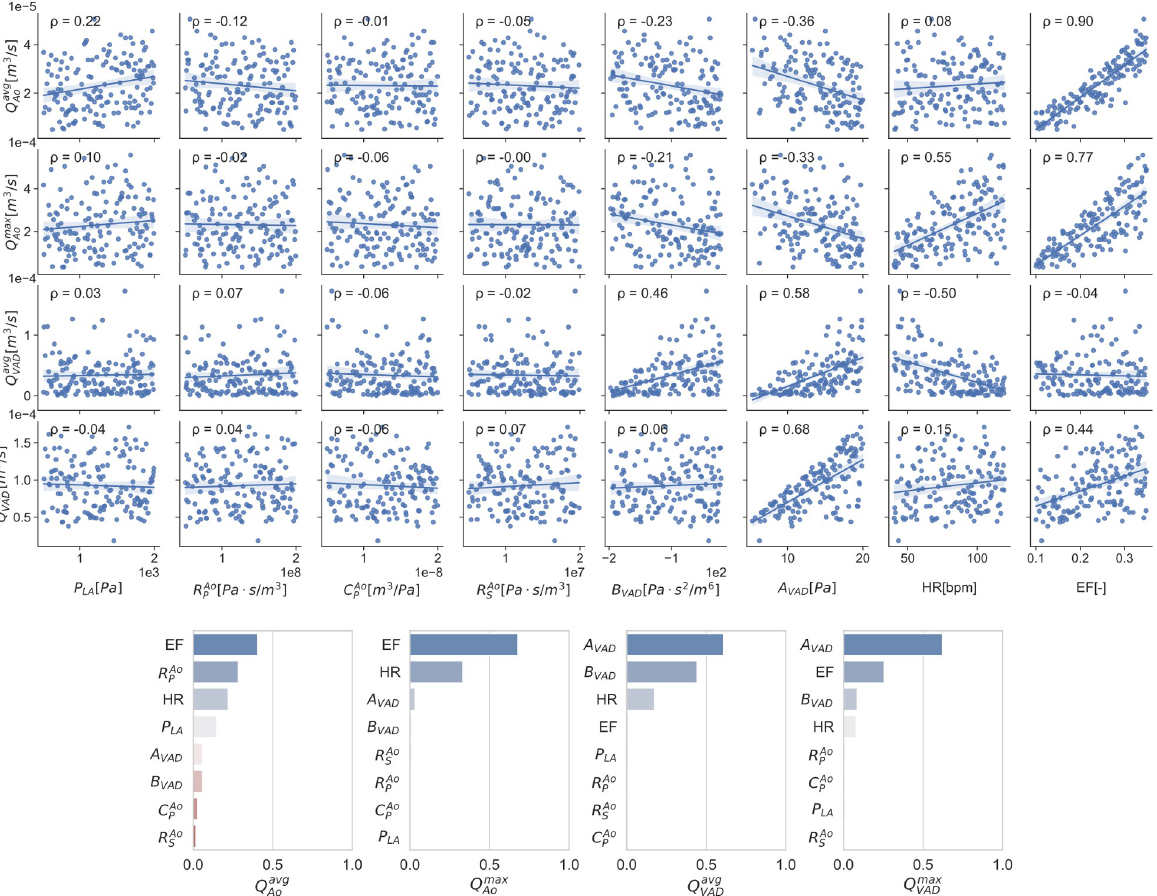
Fig 3. Scatter plots and total Sobol indices tornado plots for the 8 input variables and the 6 QoIs. The scatter plot also shows the Pearson’s linear correlation number ρ in the top left corner. Units are intentionally avoided in the Y-axis of the total Sobol indices tornado plot to ease its